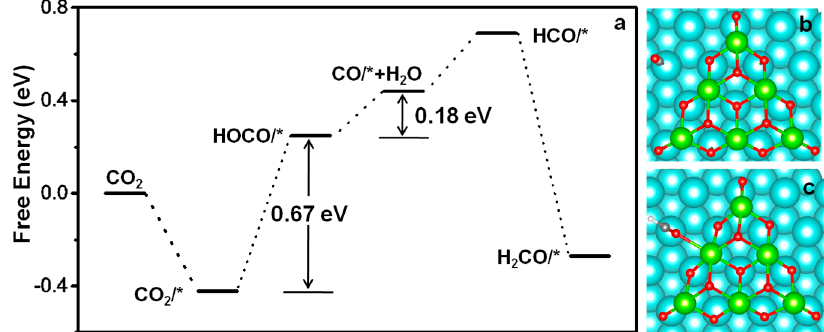
Figure 6. Free energy diagrams for the carbon monoxide. ( a ) reaction path for the formation of CO, ( b ) CO*, ( c ) HCO*.